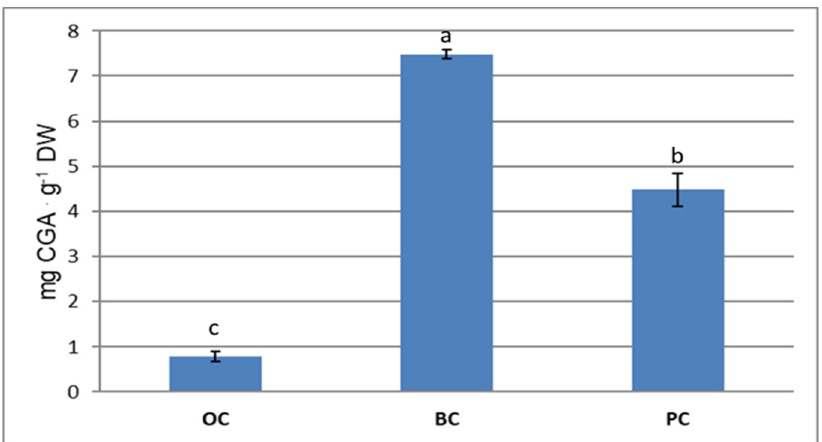
Figure 4. Chlorogenic acid (CGA) content (mg CGA. g − 1 DW) in orange carrot (OC), black carrot (BC) and purple “Polignano” carrot (PC) extracts. Data are the means ± SDs ( n = 3). Different letters indicate statistically significant differences at p ≤ 0.0001.